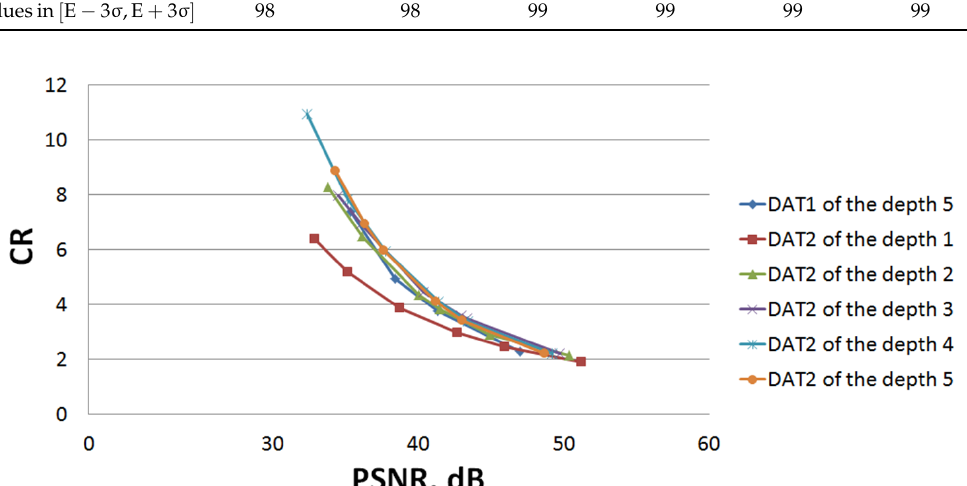
Figure 11. Dependence of the mean value of CR on the mean value of PSNR.